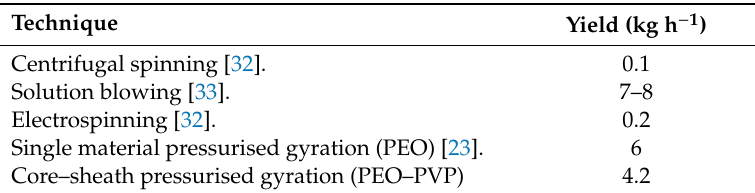
Table 1. Comparison of core–sheath polymer